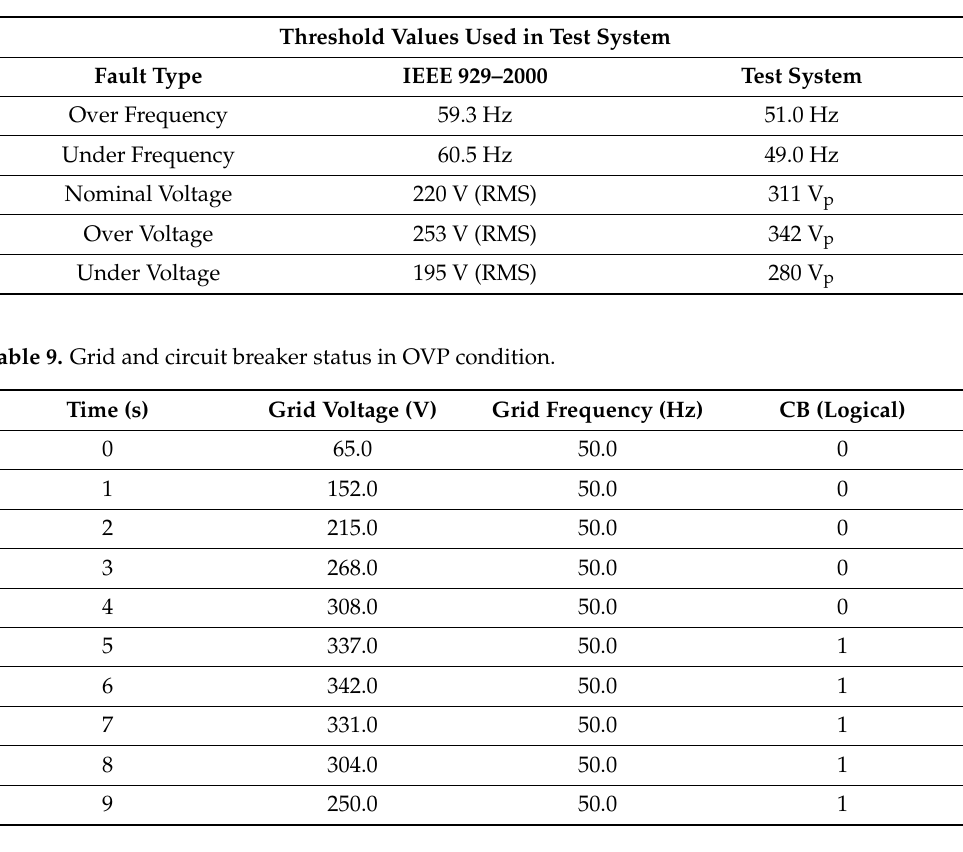
Table 8. Threshold values used in the experimental system.